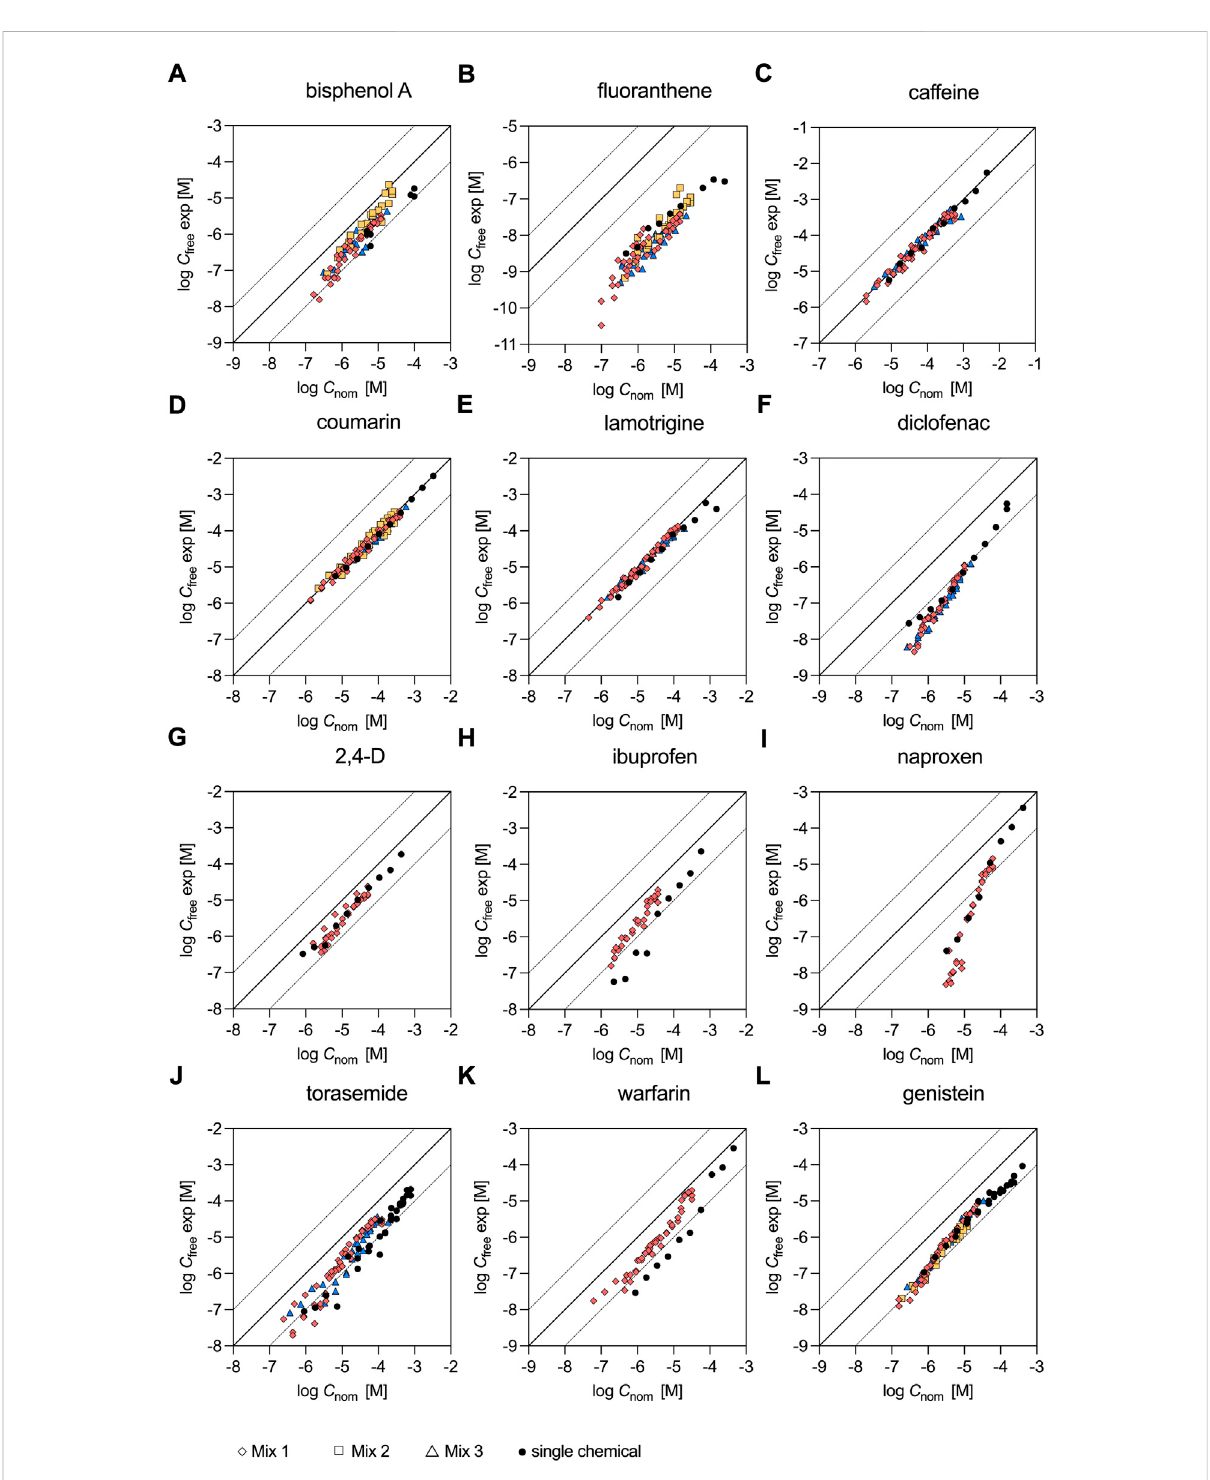
FIGURE 1 Freely dissolved concentrations of chemicals tested individually and in mixtures. Single chemical data stem from (A) Henneberger et al. (2019); (B) , (D) present study; (C) , (E) – (L) Huchthausen et al. (2020). Mixture data were measured in the present